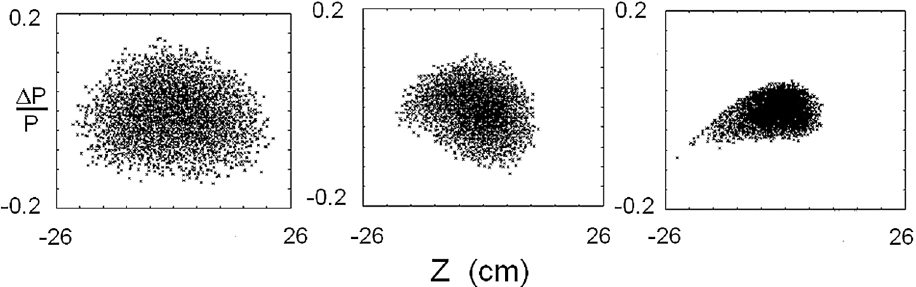
FIG. 8. Particle tracking results showing adiabatic bunch compression along the linac. The longitudinal phase space ( z , (cid:1) p=p ) is shown before (left), in the middle (center), and at the end (right) of acceleration.